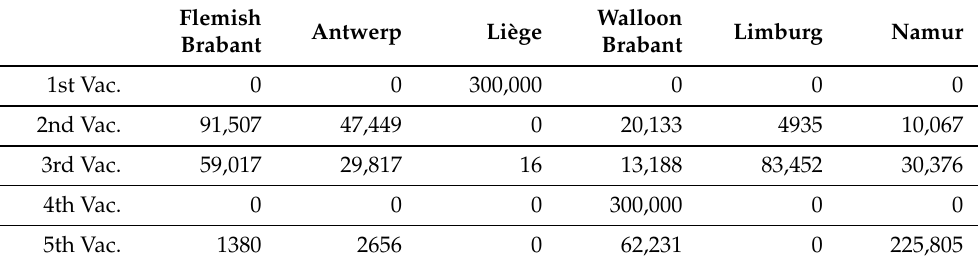
Table 9. Vaccines corresponding to the most vaccinated subdivision of the best vaccination plan obtained from SEAIRV model. Flemish Antwerp Liège Brabant